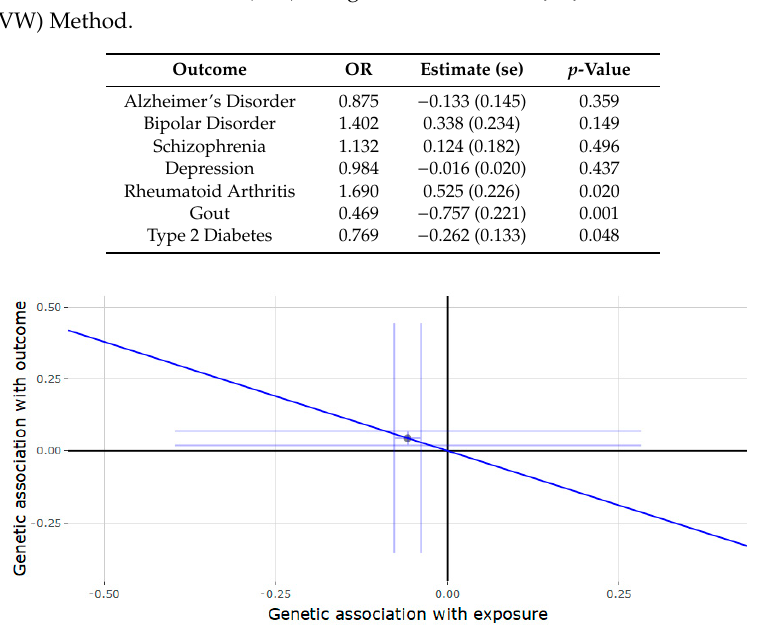
Figure 1. Genetic association of gout against genetic association of testosterone ( JMJD1C locus). The slope (dark blue line) represents the causal association of testosterone with gout (generated via inverse variance weighted Mendelian randomization), while the point on the plot and the lights around it (light blue lines) represent the SNP and its confidence intervals. Genes 2020 , 11 , 721